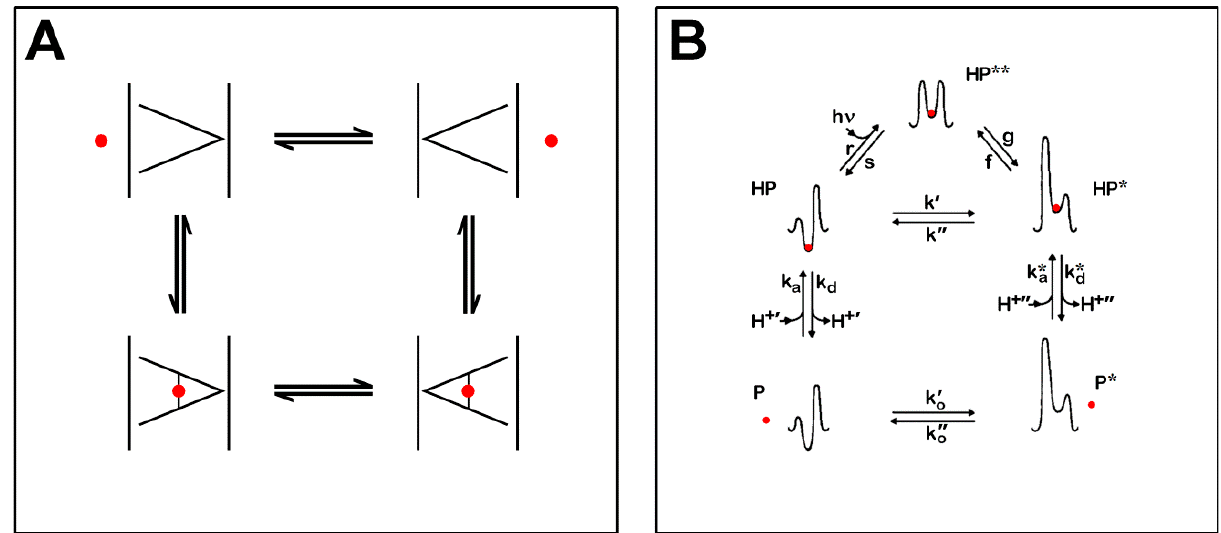
Figure 5. Original mechanistic concepts in which the ion-binding sites are not displaced during the transport process rather than the pro- tein structure that controls access to these sites. A: The first proposal was the so-called gate type non-carrier mechanism by C.S. Patlak 31 in which two different conformational states of the protein generate alternatingly access to immobile ion sites from either side of the mem- brane. (Scheme adapted from Ref. 31). B: The second proposal is a channel mechanism in which ions diffuse through a low-resistance access channel (or ‘ion well’) to a binding site inside the membrane domain of the transporter, which is framed by mobile barriers on either side that control access from the outside. Here it is applied to the light-driven proton pump bacteriorhodopsin. In this representation the energy profiles of the access channels were omitted on both sides.(Scheme adapted from Ref.